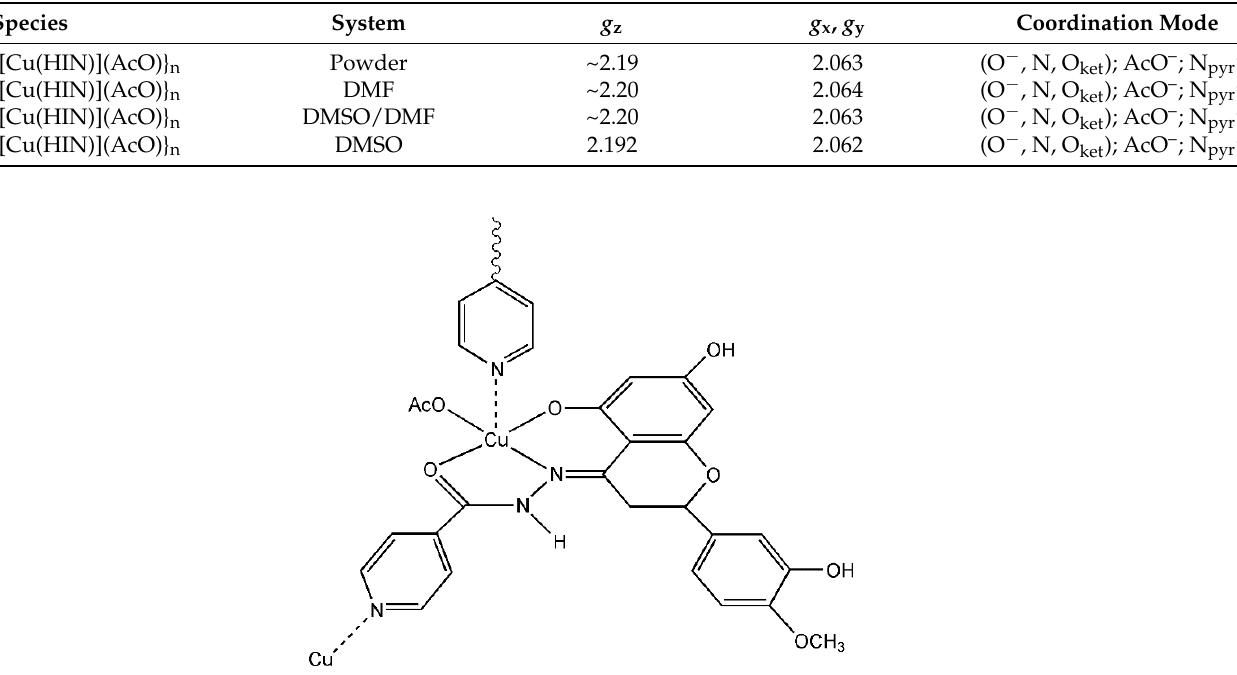
Figure 4. Structure of the polynuclear species {[Cu(HIN)](AcO)} n . The characteristic signal at half-field (centred at g = 4.28, Figure S5), due to the for- bidden ∆ M s = ± 2 transition [45], confirms the magnetic interaction between neighbouring copper(II) ions and the existence of a polynuclear species in the organic solution.